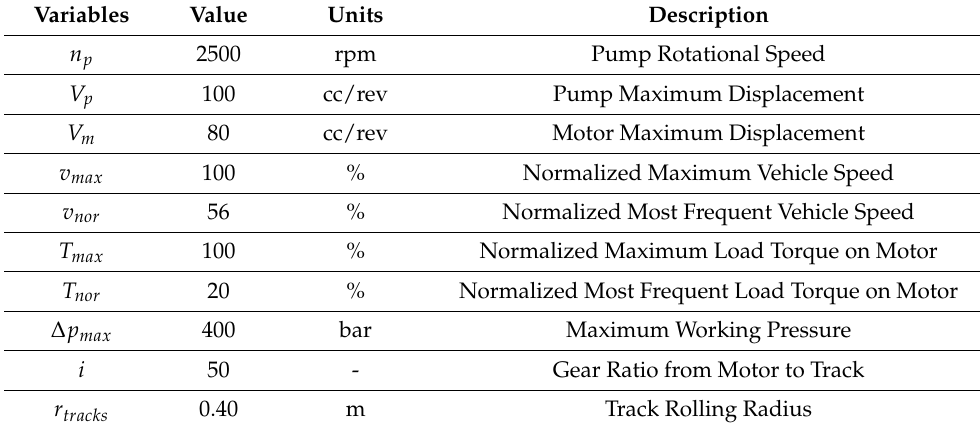
Table 2. Important HT Design Parameters.